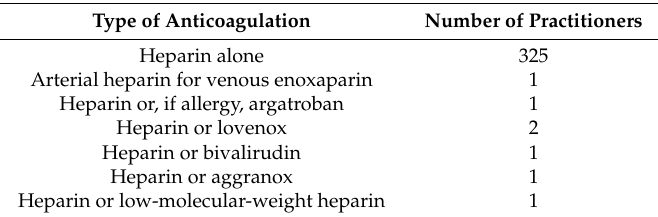
Table 1. Type of systemic anticoagulation used during thrombolysis.